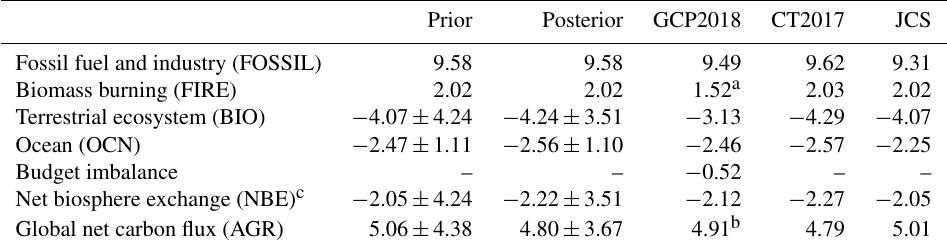
Table 3. Mean global carbon budgets during the 2010–2015 period estimated in this study as well as those from the prior fluxes, GCP2018, CT2017, and JCS (PgCyr − 1 ).